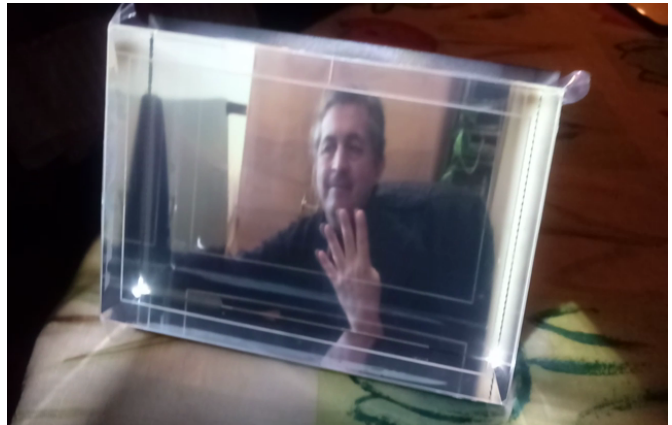
Figure 4. Multi-view hologram output from morphed stereoscopic images. See more in the video demo at: